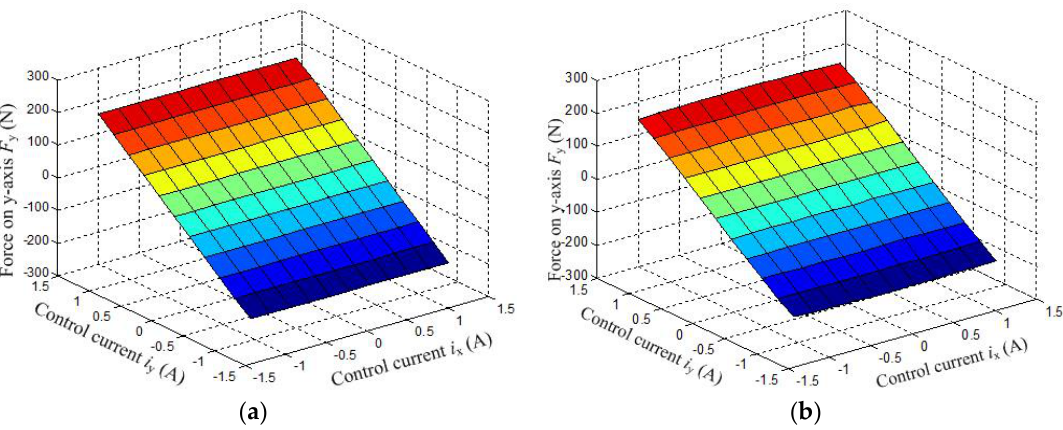
Figure 11. Curves of relationship between suspension force on y ‐ axis and radial control current. ( a ) Analytical results; ( b ) Finite element method (FEM) results.